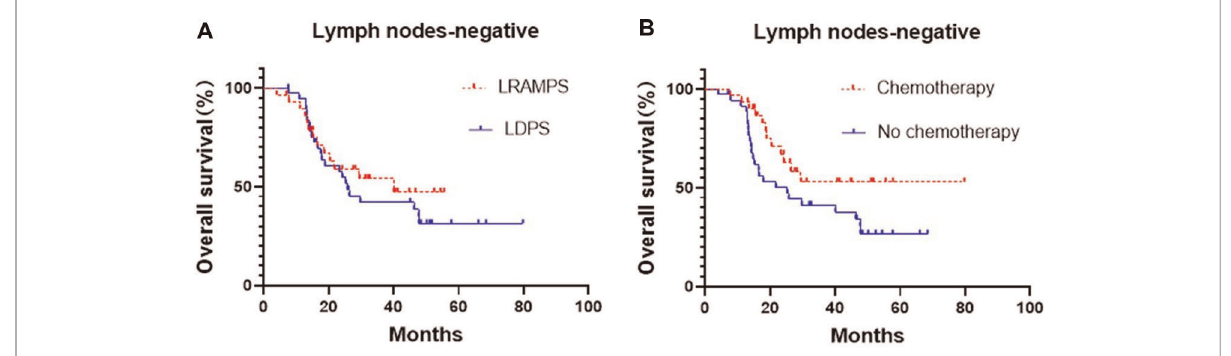
FIGURE 2 Median OS of negative lymph nodes patients, ( A ) LRAMPS: 40.1 months; LDPS: 25.8 months. ( B ) Chemotherapy: not reach; no chemotherapy: 25.3